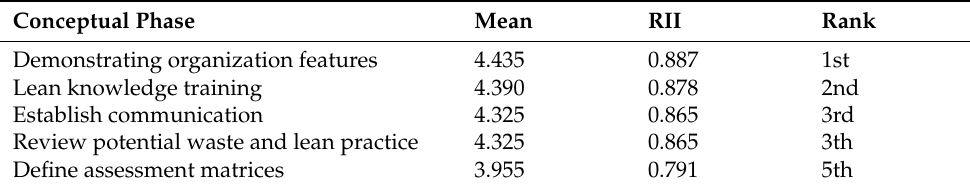
Table 12. Monitoring and controlling quality in the management of the construction